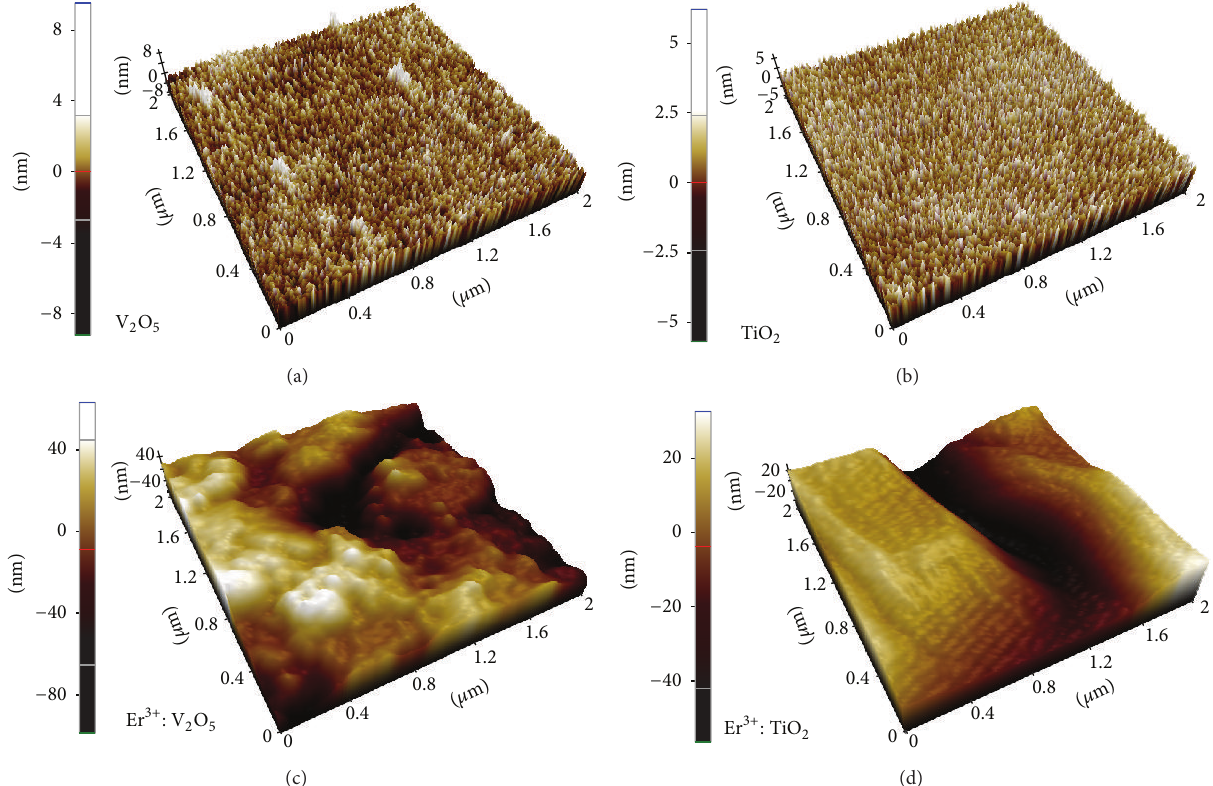
Figure 5: Atomic force microscopy picture of the films deposited on SLG substrates.